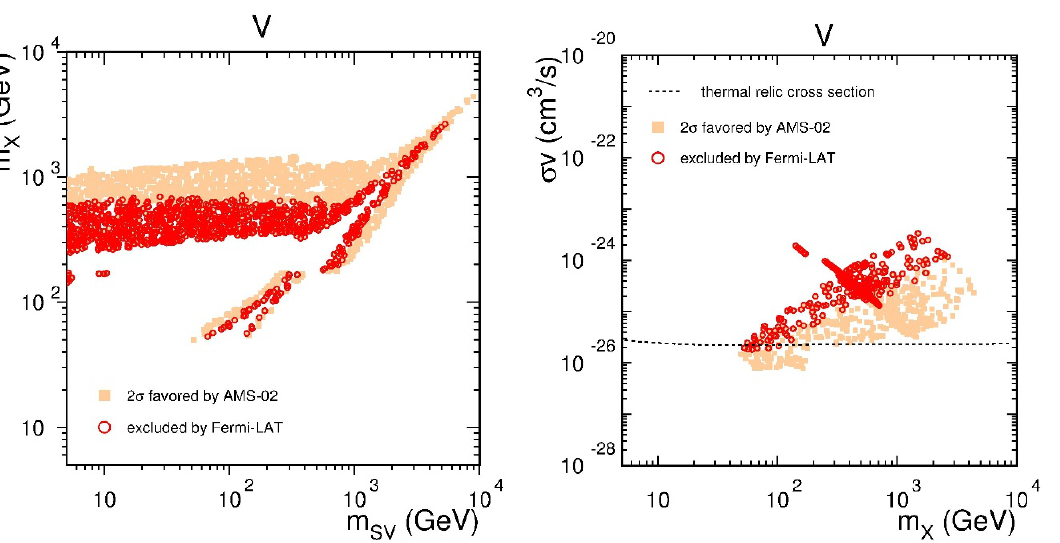
JHEP01(2018)151